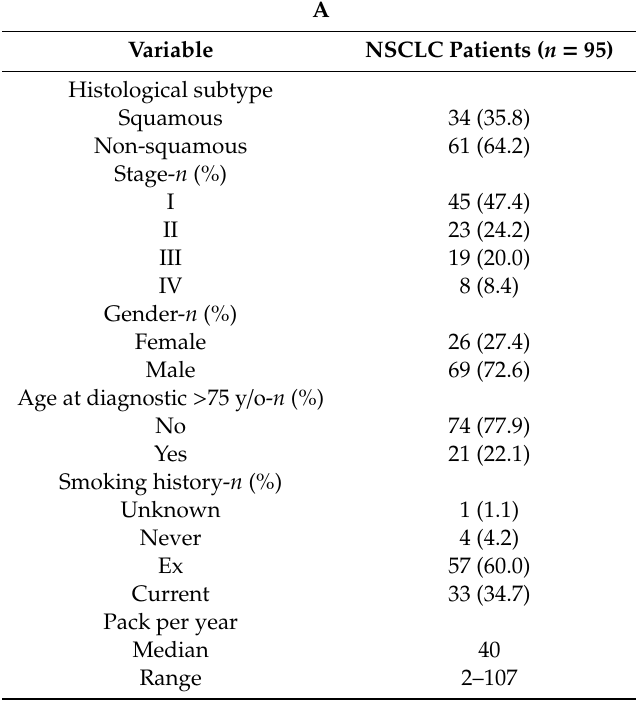
Table 1. Clinical and pathological characteristics of (A) NSCLC patients, (B) SCLC patients, and (C) healthy